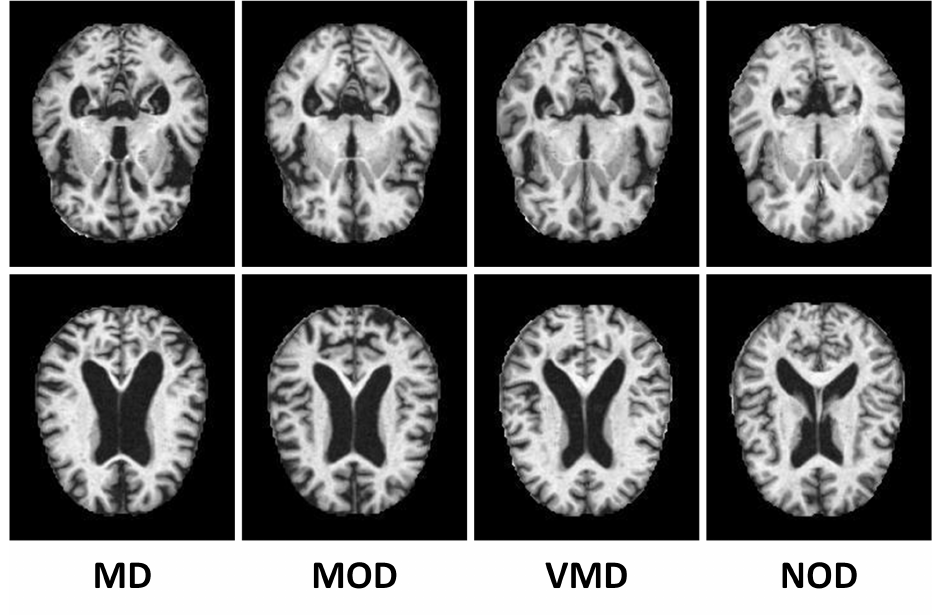
Figure 2. The image samples from AD dataset without up-sampling through